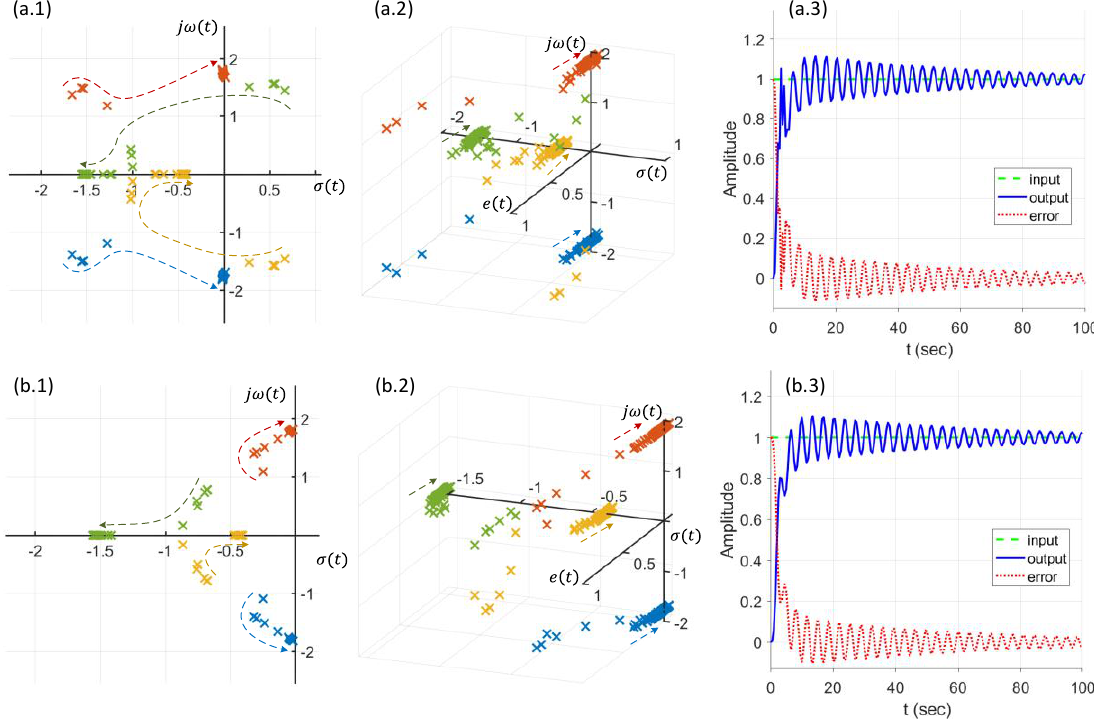
Figure 11. Dynamic pole motions of the controlled hybrid soft leg and the controlled system response by error change with the gains of ( a ) K pf = 1.1, K vf = 0.3, α = 10, and β = 2, and ( b ) K pf = 1.1, K vf = 0.3, α = 0.1, and β = 2. The initial system responses were slightly distinct with different peaks, but the rest of the response remained similar. The arrows indicate the direction of pole motions.